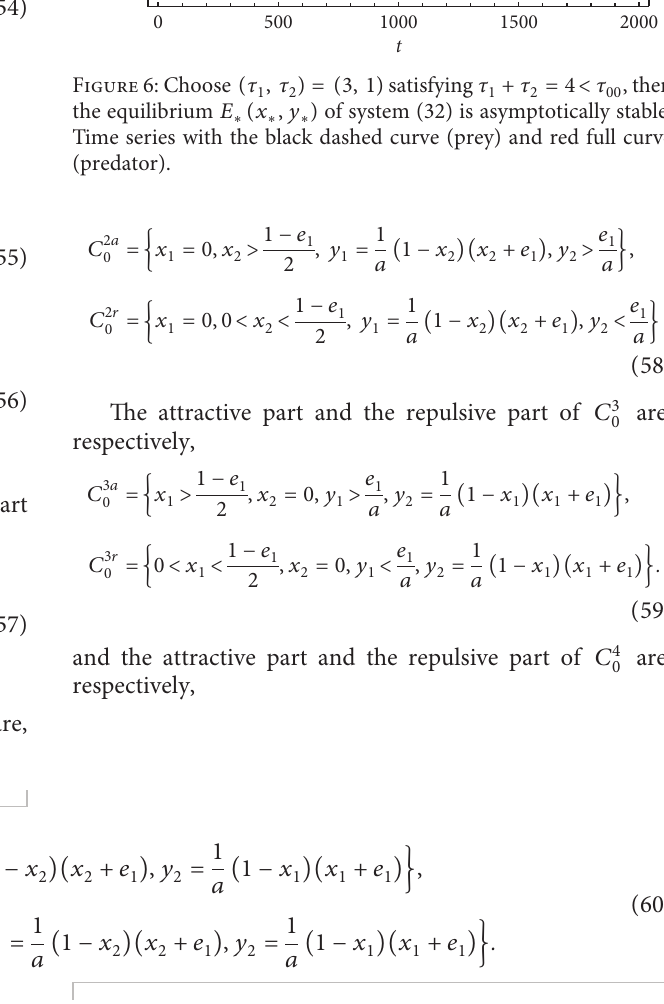
+ τ � 4 < τ , then 1 2 00